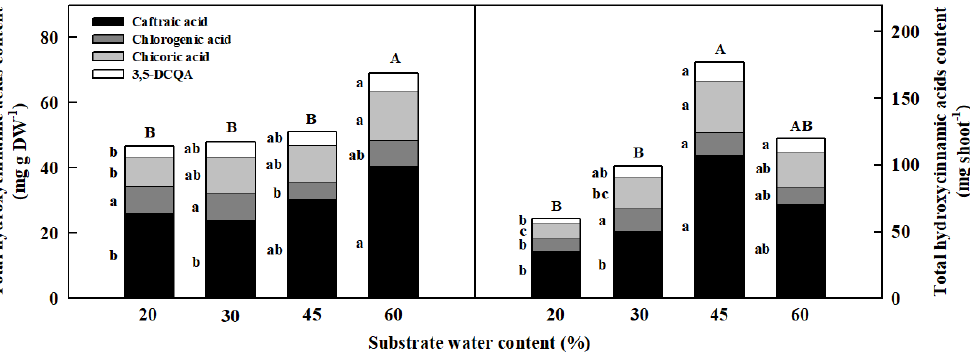
Figure 7. E ff ect of substrate water content on hydroxycinnamic acids’ (HCAs) content: Total HCAs’ content per unit dry weight ( A ) and per shoot ( B ) of Crepidiastrum denticulatum grown under four di ff erent substrate water content levels for 5 weeks. The data indicate the means ± S.E. ( n = 12). Di ff erent lowercase letters indicate statistical di ff erence in each individual compound by Tukey’s Studentized Range Test at p < 0.05. Di ff erent uppercase letters indicate statistical di ff erence in total HCAs by Tukey’s Studentized Range Test at p <